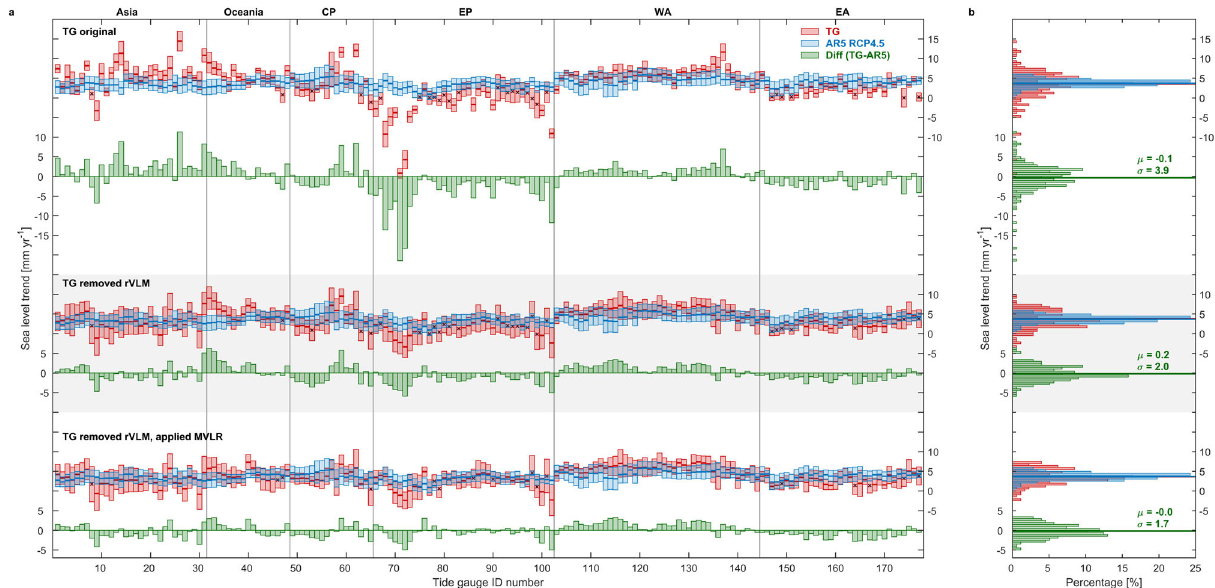
Fig. 5 Regional sea-level trends (2007 – 2018) from tide-gauge observations compared with the sea-level projection. Sea-level trends [mm yr − 1 ] are based on tide-gauge observations (TG; red), the Intergovernmental Panel on Climate Change (IPCC) Fifth Assessment Report (AR5) projection under Representative Concentration Pathway (RCP) 4.5 scenario (blue) and their difference (TG minus AR5; green) at each tide-gauge station, for a box plots and b histogram. Error bars indicate 90% con fi dence level, and trends which are not signi fi cant at 90% con fi dence level denoted as cross symbols. Region de fi nition in a is shown in Fig. 2. TG trends have no adjustment in top panel, residual vertical land motion (rVLM) adjustment in middle panel, and rVLM adjustment and climate variability removed via multiple variable linear regression (MVLR) model in bottom panel. In histograms b , the bin width is 0.5 mm yr − 1 , horizontal lines present weighted-mean trend ( μ ) at all TG stations, σ denotes the standard deviation of the trend at all TG